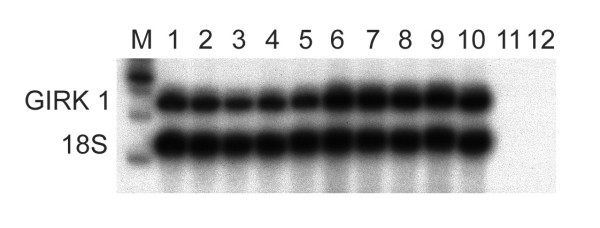
Comparison of GIRK1 mRNA expression levels by relative competitive RT-PCR in MDA-MB-453 cells treated with propranolol constantly for 6 days. Propranolol (1 μM) was added daily for six days. cDNA was amplified by PCR using GIRK1 primers and 18S primers/competimers. Lanes 1–5) untreated control; Lanes 6–10) propranolol treated cells; Lane 11) untreated control, RT reaction without MMLV; Lane 12, MDA-MB453 treated with propranolol, RT reaction without MMLV. Densitometry values were determined using the phosphoimager. Densitometry values of the bands for Girk 1 were normalized by the densitometry values of the bands for the 18S primers/competimers. Normalized values for control were 0.5494 ± 0.0285 (SD); and normalized values for propranolol treated were 0.9028 ± 0.0348 (SD), p < 0.0001. The bands were consistent with the expected sizes, 441 bp for the GIRK 1 primers and 324 bp for the 18S primers/competimers.